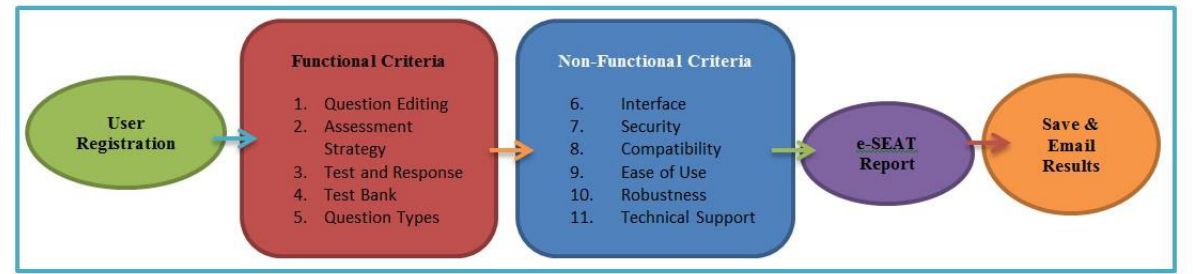
Figure 3. The e-SEAT process.